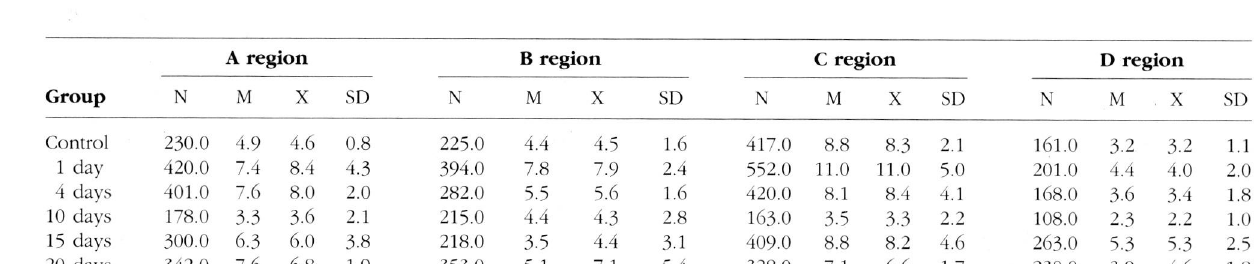
Fig. 6. - Box and whisker plots representing the numbers of mast cells in the skin of control rats and those infested with Dermatobia hominis larvae for different periods (Kruskal-Wallis test).